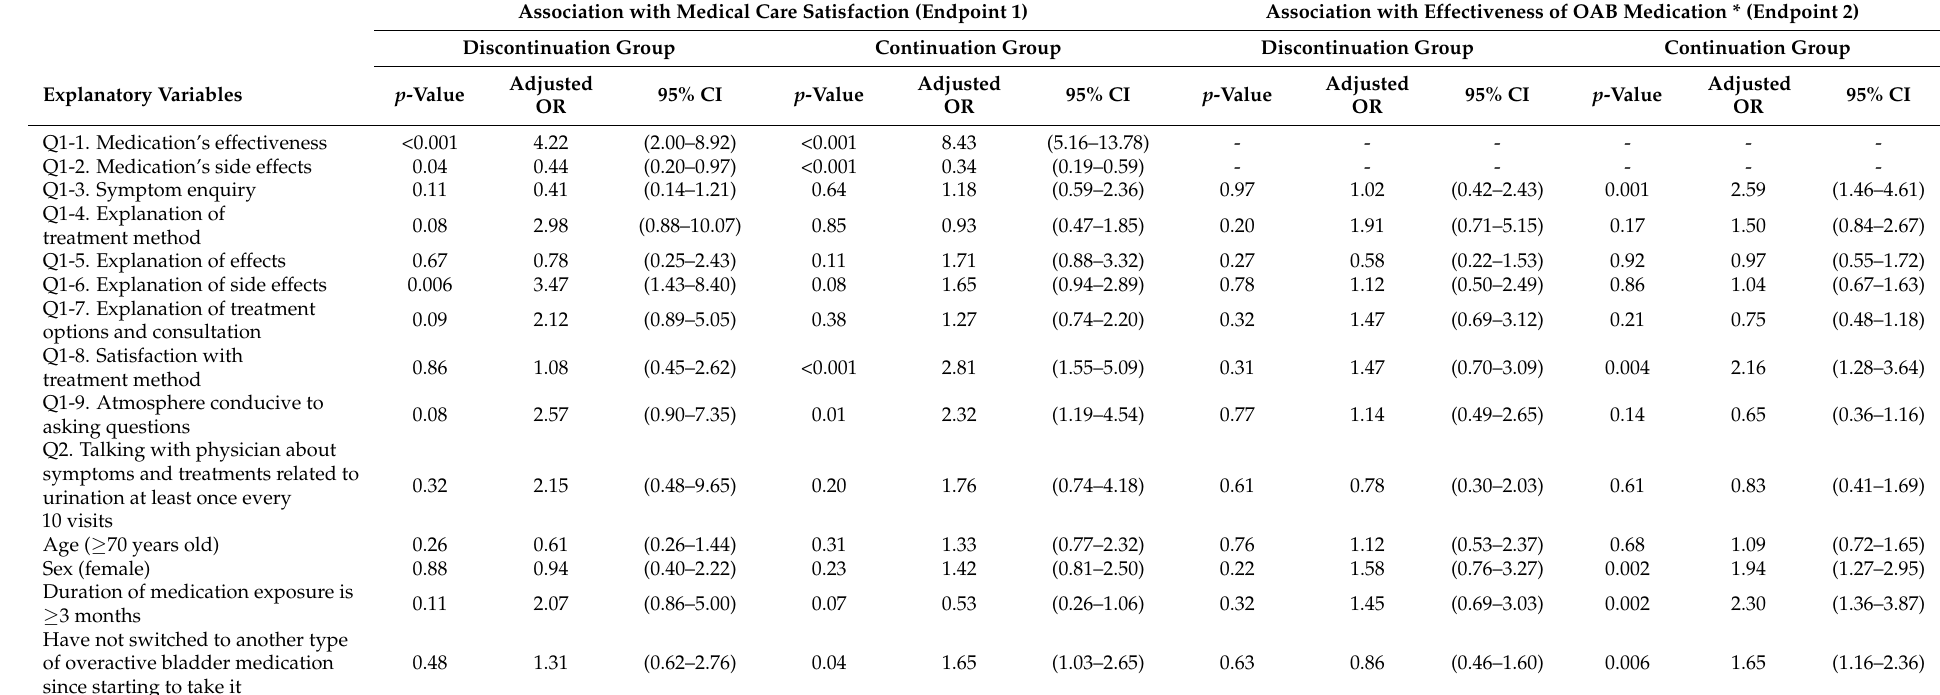
Table 4. Stratified analysis in the discontinuation and continuation